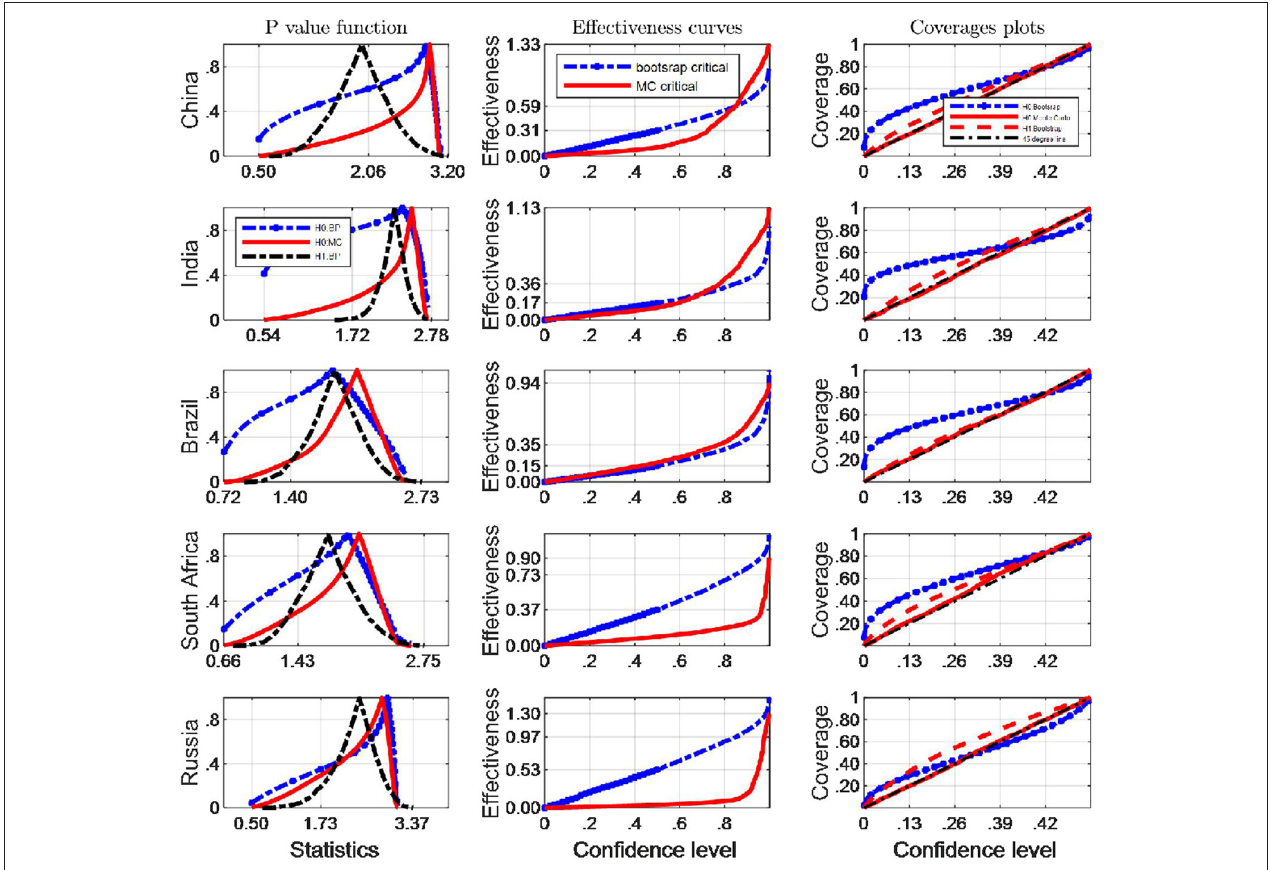
FIGURE 8 | A comparison of confidence intervals of Monte Carlo and counterparts of bootstrap for the Berkes test using EF